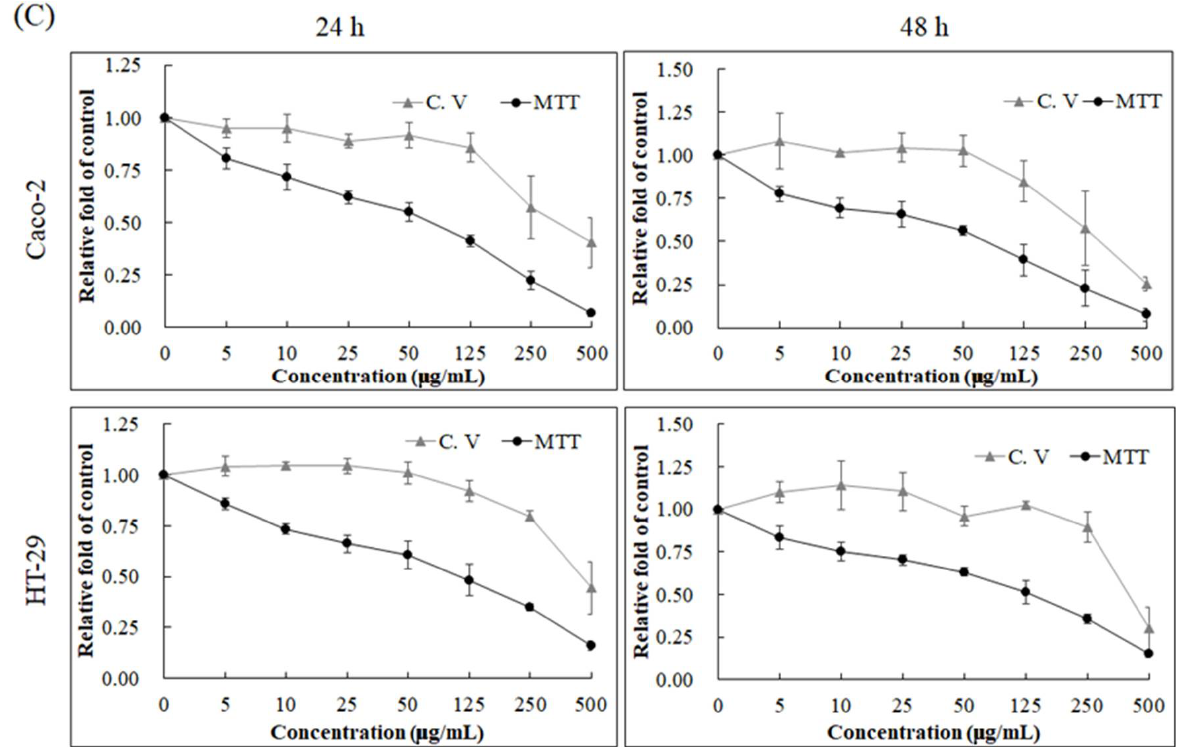
Figure 3. Effect of EEFPP on the growth in Caco-2 and HT-29 colorectal cancer cells. ( A ) Effects of EEFPP on cell morphology after 24 h treatment. ( B ) Crystal violet staining of cells after EEFPP treatment for 24 h. ( C ) Quantitative analysis of MTT and crystal violet staining (C. V) in cells treated with EEFPP for 24 h and 48 h. Data are shown as means ± SD ( n = 3). MTT data of Caco-2 are adopted from Figure 2B.